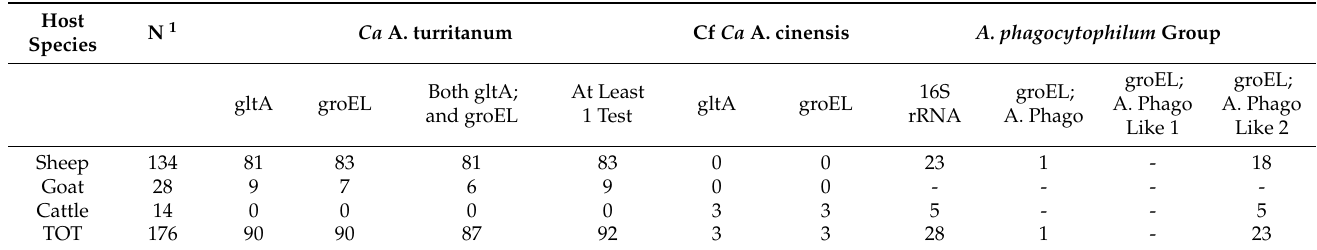
Table 2. Positivity of PCR tests specific for Anaplasma strains genetically related to A. phagocytophilum and A.